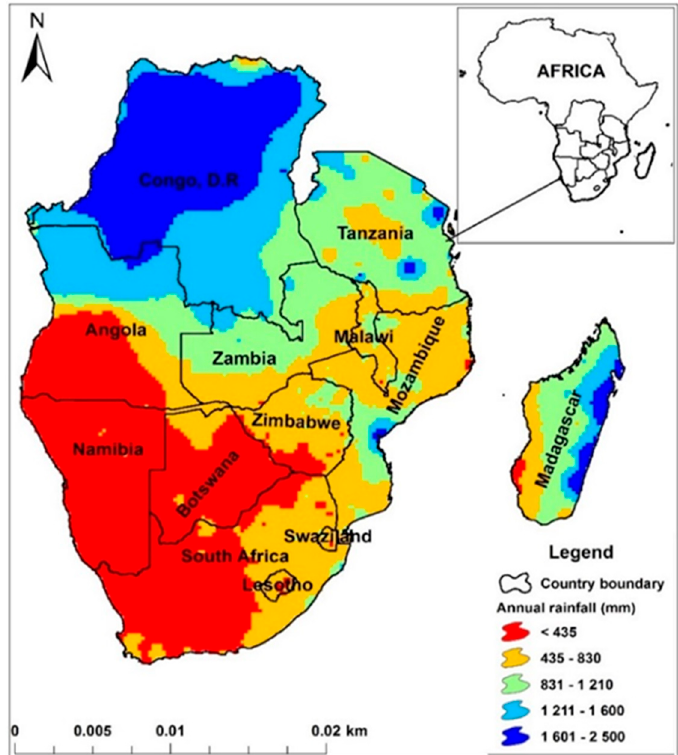
Figure 1. Locational map of southern African showing annual rainfall distribution. Source: Developed by authors.